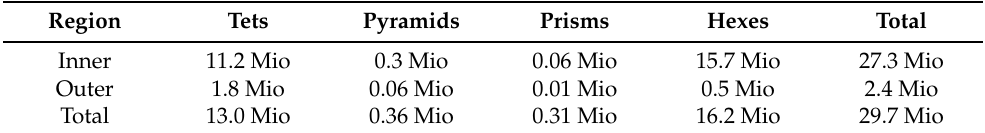
Table 4. Cell counts for case PPTC VP1304.